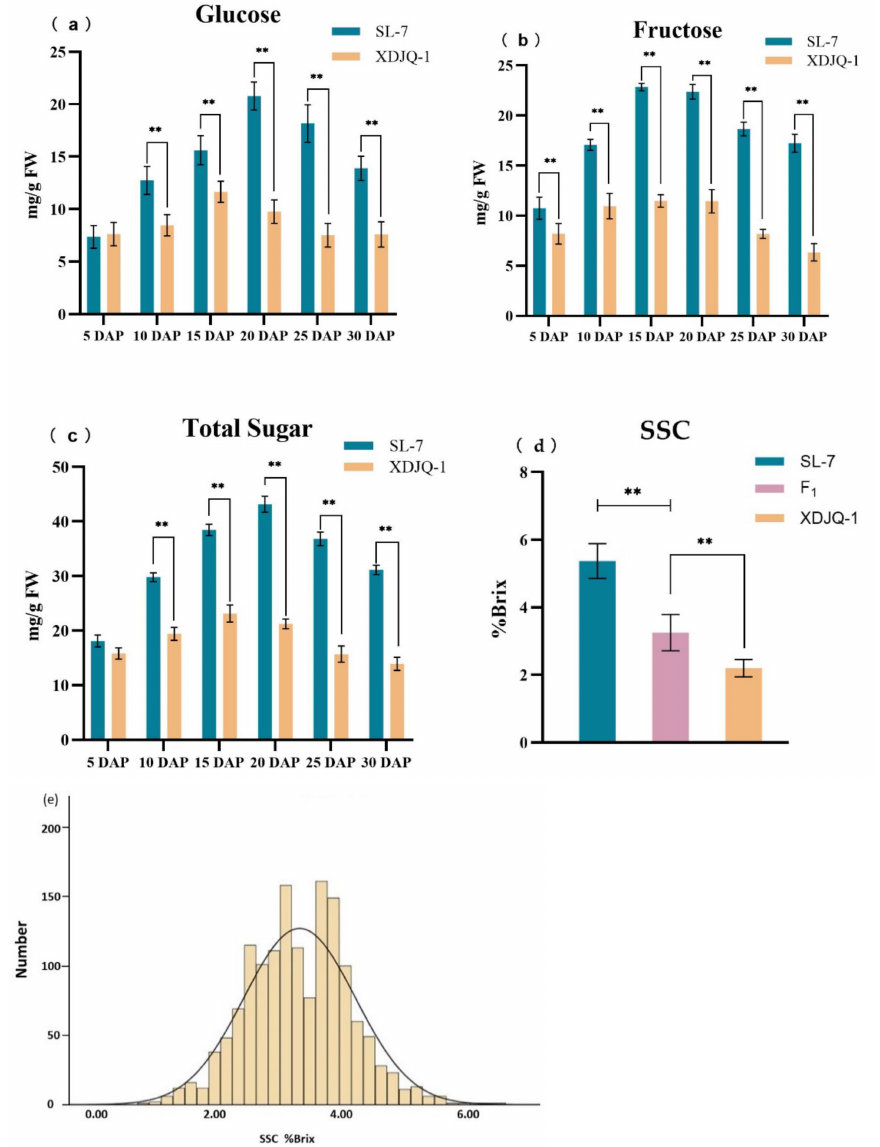
Figure 1. SSC and sugar content of wax gourd. ( a ) Glucose content of SL-7 and XDJQ-1 at 5–30 DAP. ( b ) Fructose content of SL-7 and XDJQ-1 at 5–30 DAP. ( c ) Total sugar content of SL-7 and XDJQ-1 at 5–30 DAP. ( d ) SL-7, XDJQ-1, and F 1 at 20 DAP. ** p < 0.01 ( a – d ). ( e ) SSC frequency distribution histogram of 1493 F 2 strains at 20